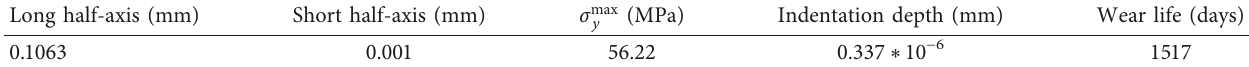
Table 3: Contact wear zone parameters.